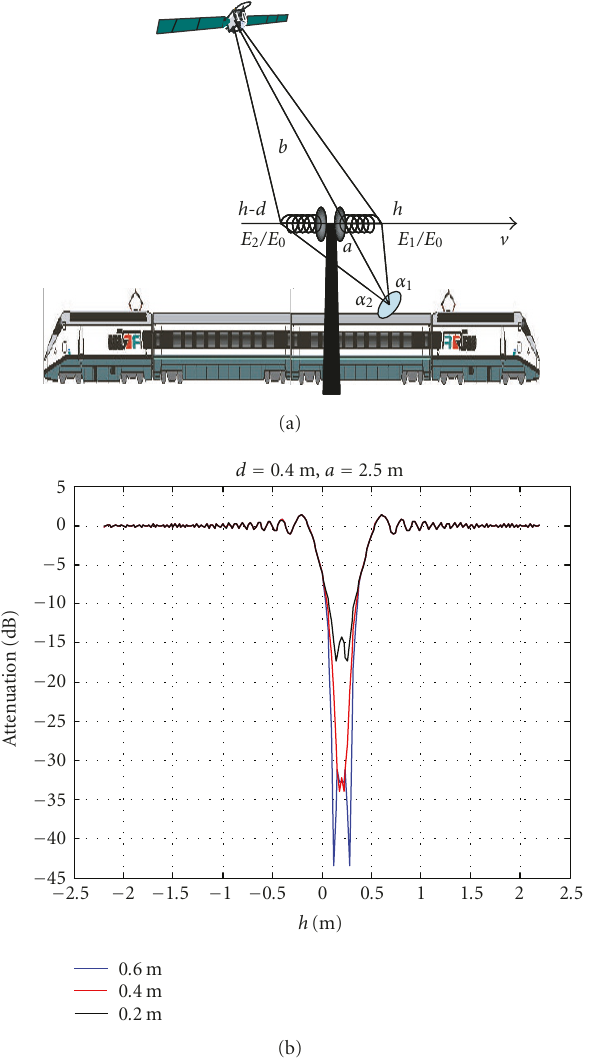
Figure 2: Knife-edge di ff raction model applied to the railway sce- nario and possible attenuation caused by power arches at Ku band for di ff erent antenna diameters.